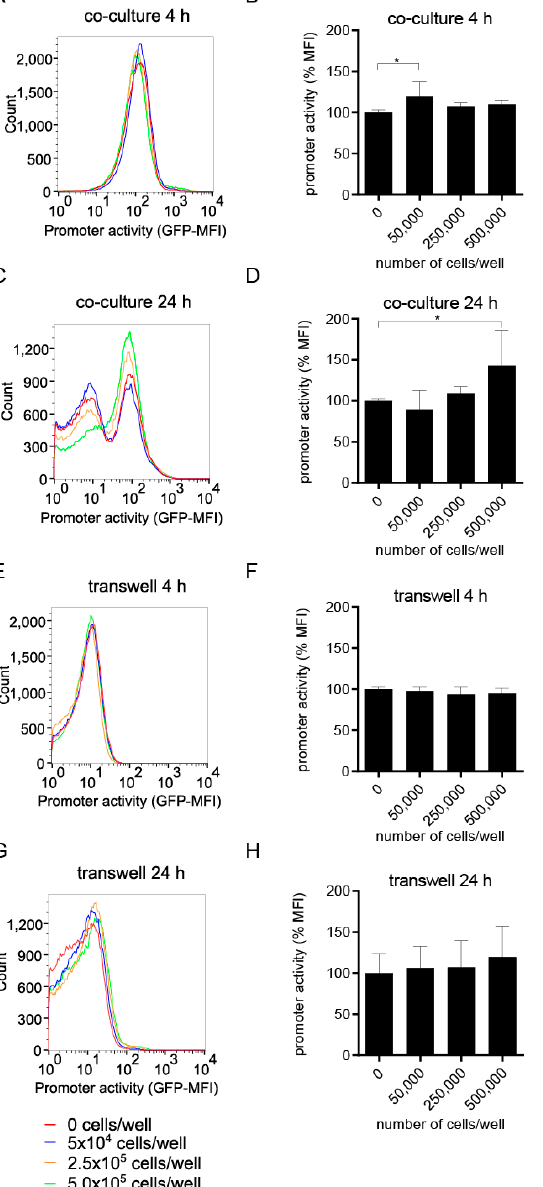
Figure 1. The epithelial cell line T24/83 induces the P2 promoter. We cultured CFT073 pPc2398:gfpmut:KAN in McCoy medium in the absence or presence of titrated amounts of T24/83 cells as indicated. Bacteria and T24/83 cells were either co-cultured (1.6 × 10 7 bacteria/well, ( A – D )) or cultured in transwells (1.6 × 10 8 bacteria/well, ( E – H )). We determined the P2 promoter activity after a culture period of 4 ( A , B , E , F ) or 24 h ( C , D , G , H ) by flow cytometry. ( A , C , E , G ) depict representative flow cytometry results. ( B , D ) show three independent experiments and ( F , H ) four independent experiments, each experiment was performed with three replicates. The measured promoter activity in ( B , D , F , H ) was normalized to the “0” control. * p < 0.05, ANOVA post-hoc Tukey. We then analyzed the ability of the human monocytic cell line THP-1, which we stimulated with LPS, to induce the tcpC promoter. Co-cultivation of the CFT073